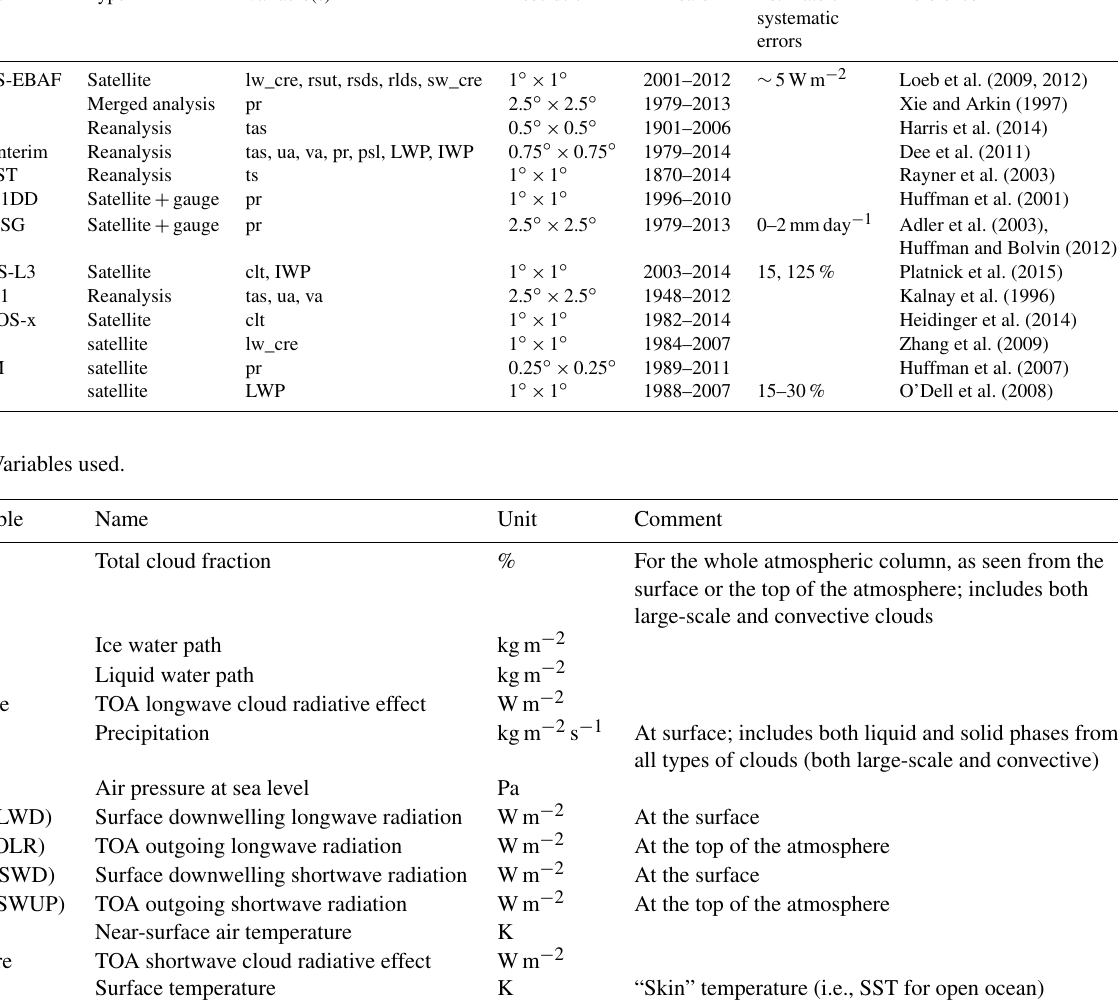
Table 3. Observationally based datasets used for the model evaluation. For variable definitions, see Table 4. Dataset